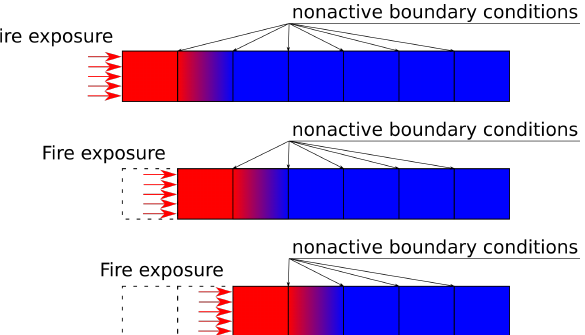
Figure 3. Implementation of a moving boundary